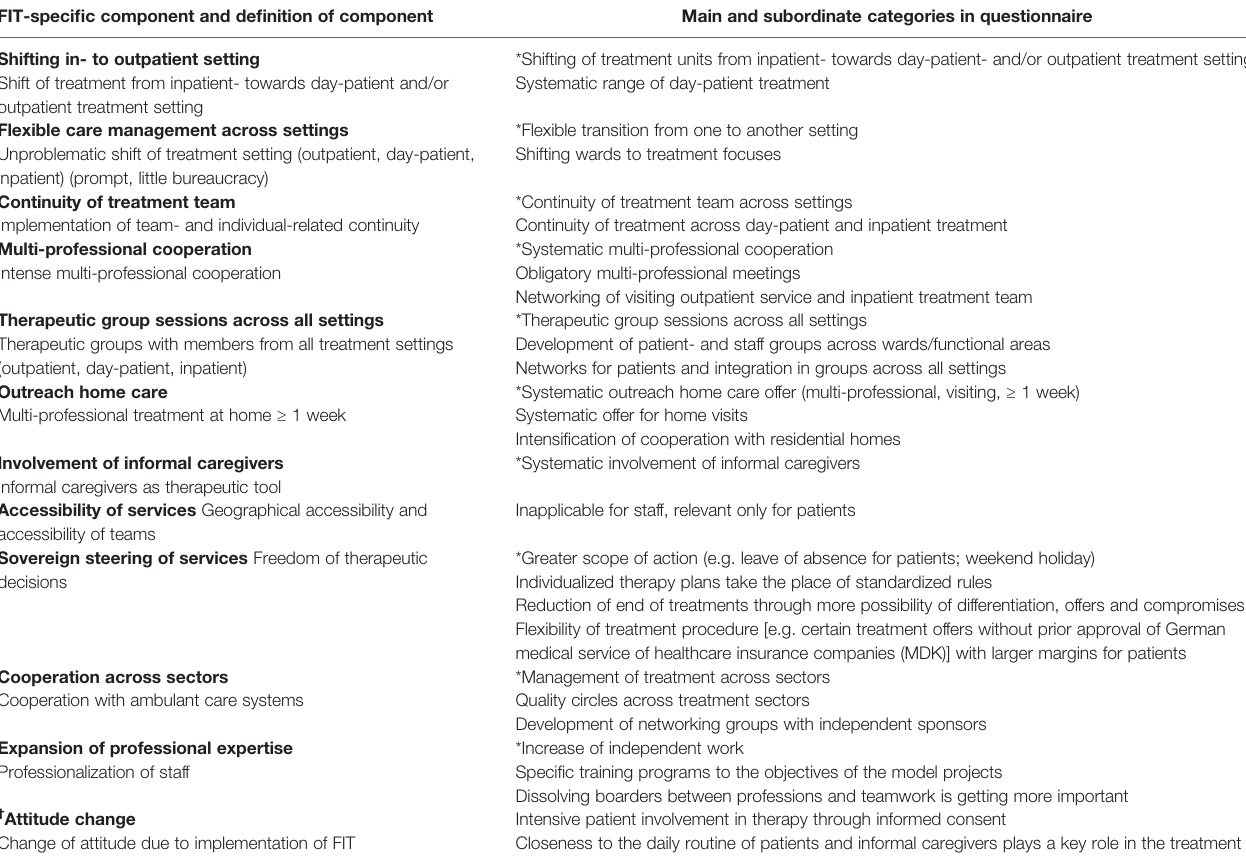
TABLE 2 | De fi nition, main and subordinate categories of FIT-speci fi c components for the questionnaire ‘ Characteristics, Structures and Procedures of Model Projects ’